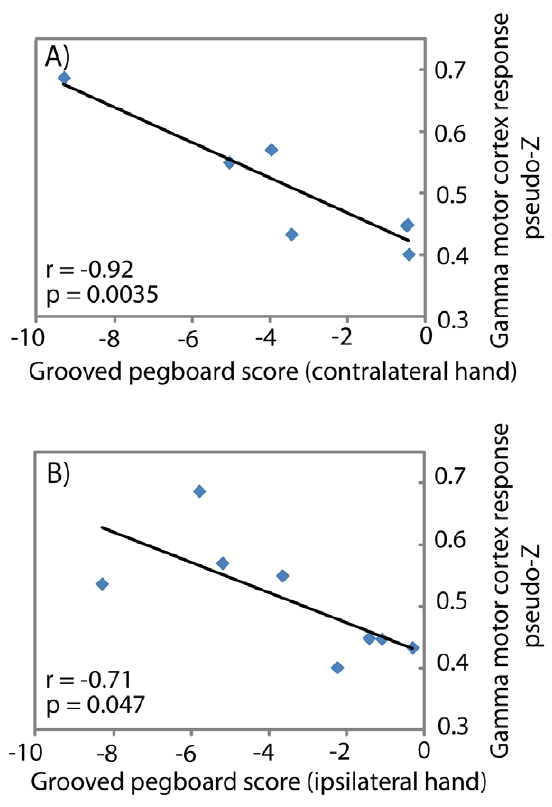
Figure 3. Altered Rolandic MEG response associated with motor ability. Gamma1 (36–44 Hz) response from Rolandic cortex in the epileptogenic cortex was correlated with performance on the grooved pegboard test using both the (A) contralateral, and (B) ipsilateral hand.